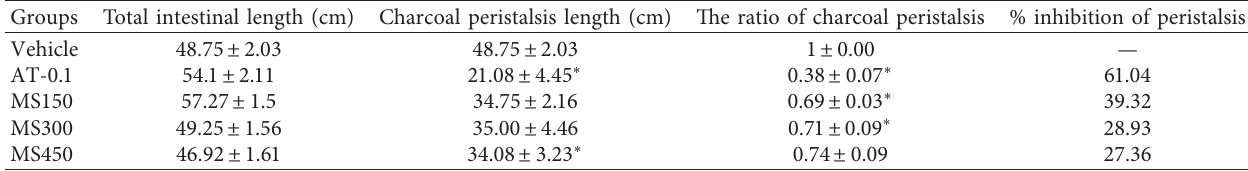
Table 2: The effect of 80% methanolic leaf extract of M. stenopetala on charcoal meal intestinal peristalsis. Groups Total intestinal length (cm) Charcoal peristalsis length (cm) The ratio of charcoal peristalsis % inhibition of peristalsis Vehicle